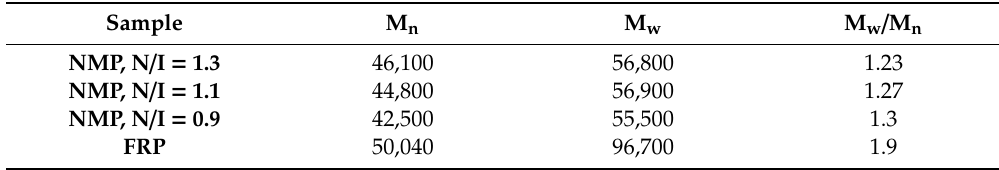
Table 1. Properties of synthesized